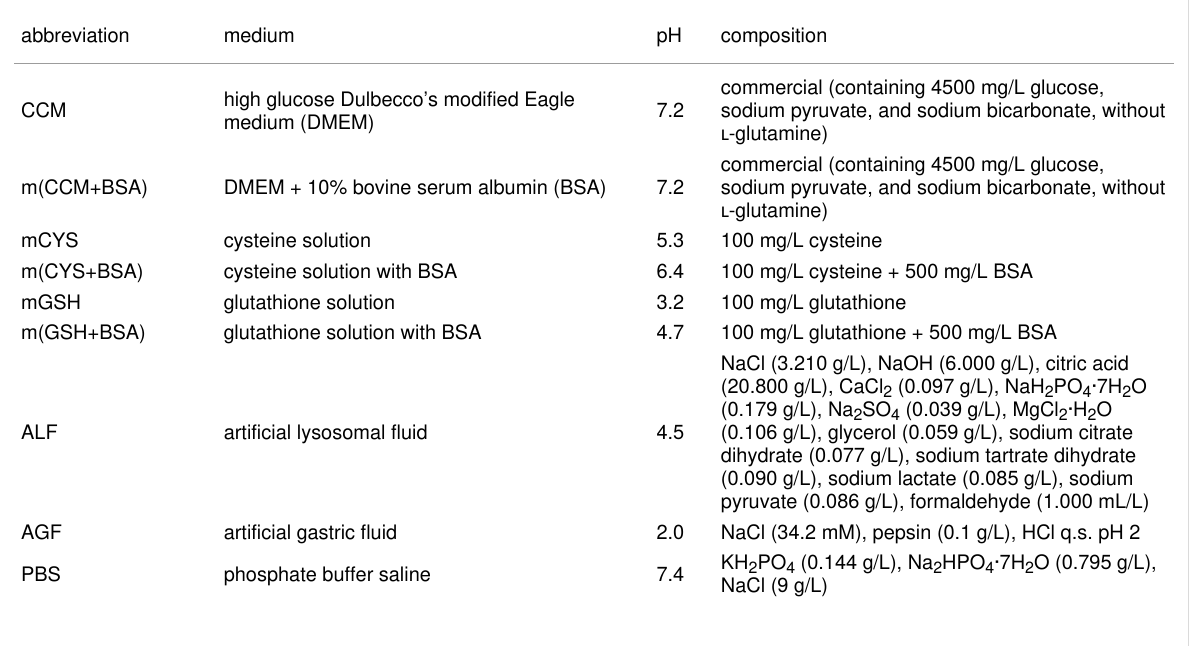
Table 1: Information on the composition and pH of biologically relevant artificial media used for the evaluation of the stability and transformation of